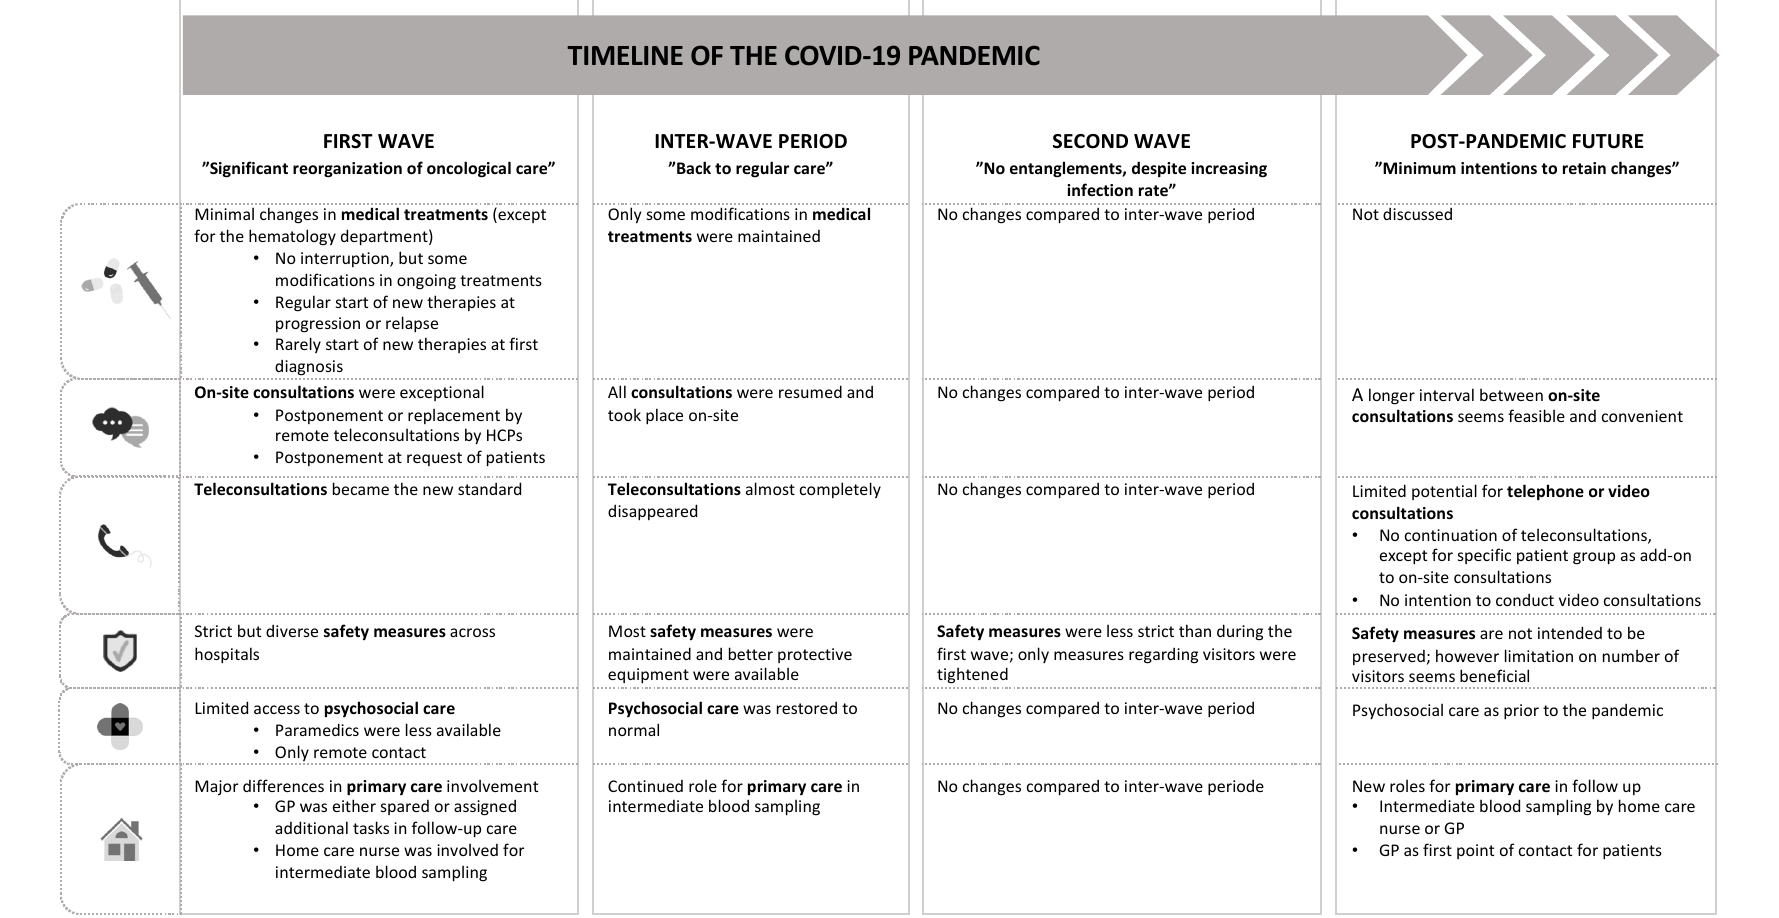
Figure 1. Overview of changes in the organization of oncological care over time and future prospects.